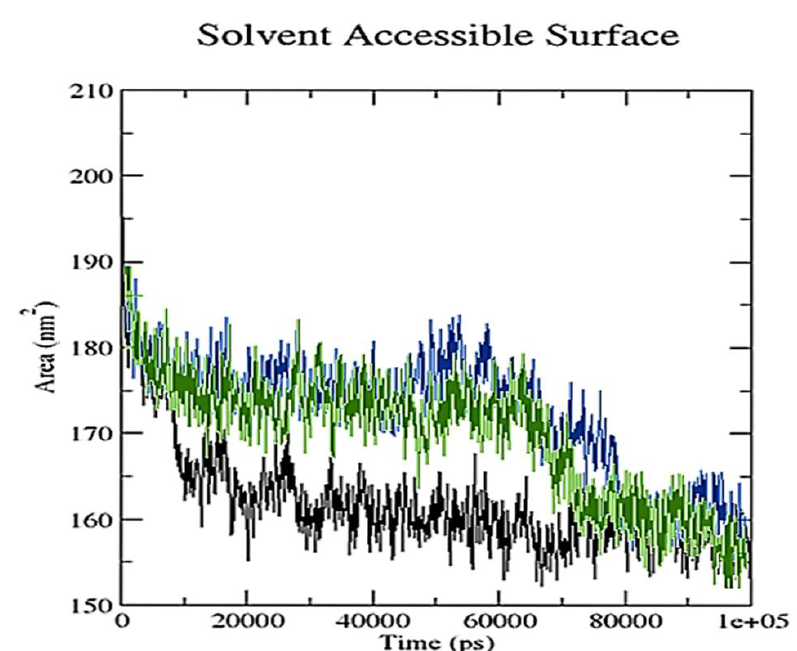
ure 15. Number of average hydrogen bonding interactions between ( a ) the RisS complex and ( b ) the CTcS complex during the 100 ns simulation period.